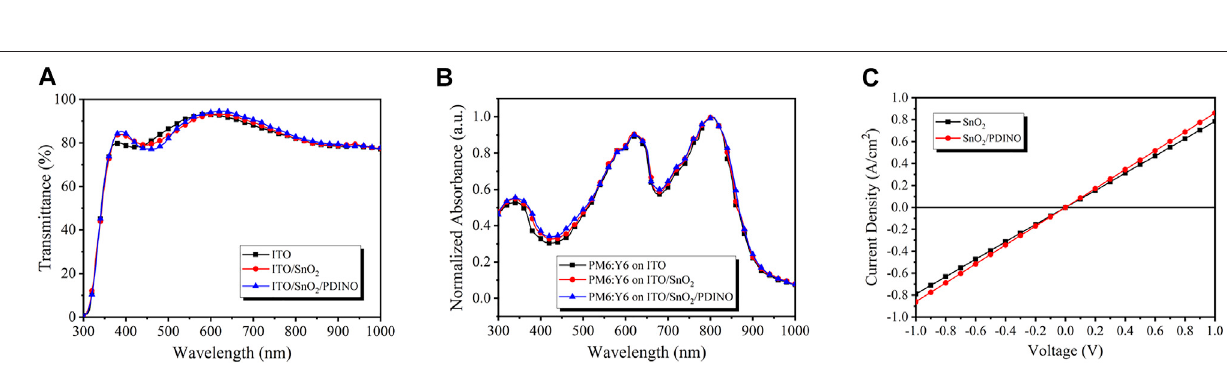
FIGURE 1 | (A) Molecular structures of organic photoelectric materials used in this study. (B) Schematic diagram of the OSC device structure.